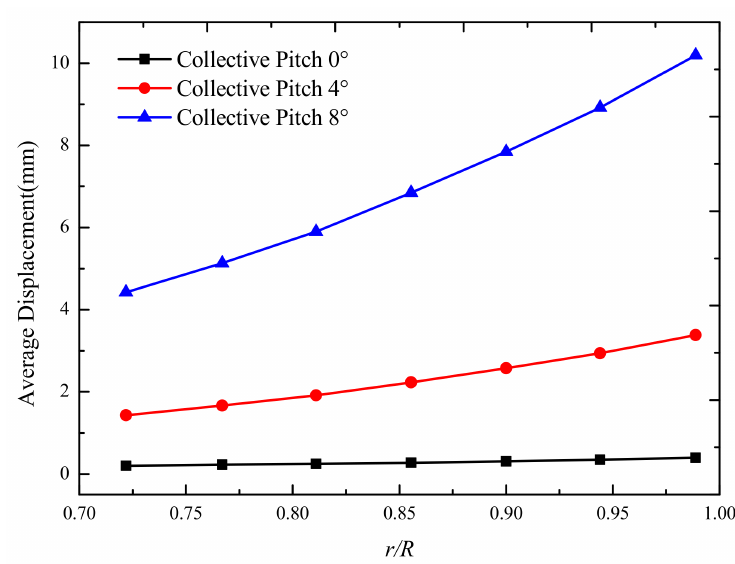
Figure 14. Comparison of average displacements at seven different radial